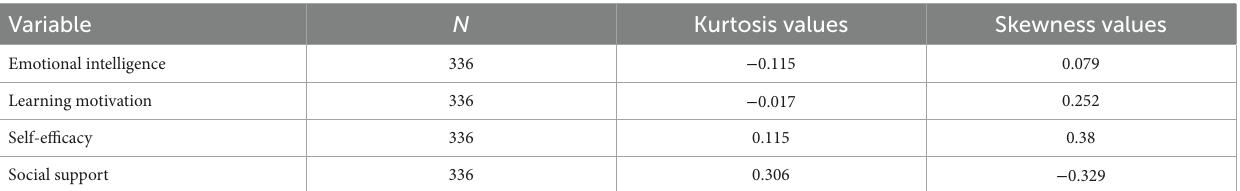
TABLE 2 Results of multivariate normality